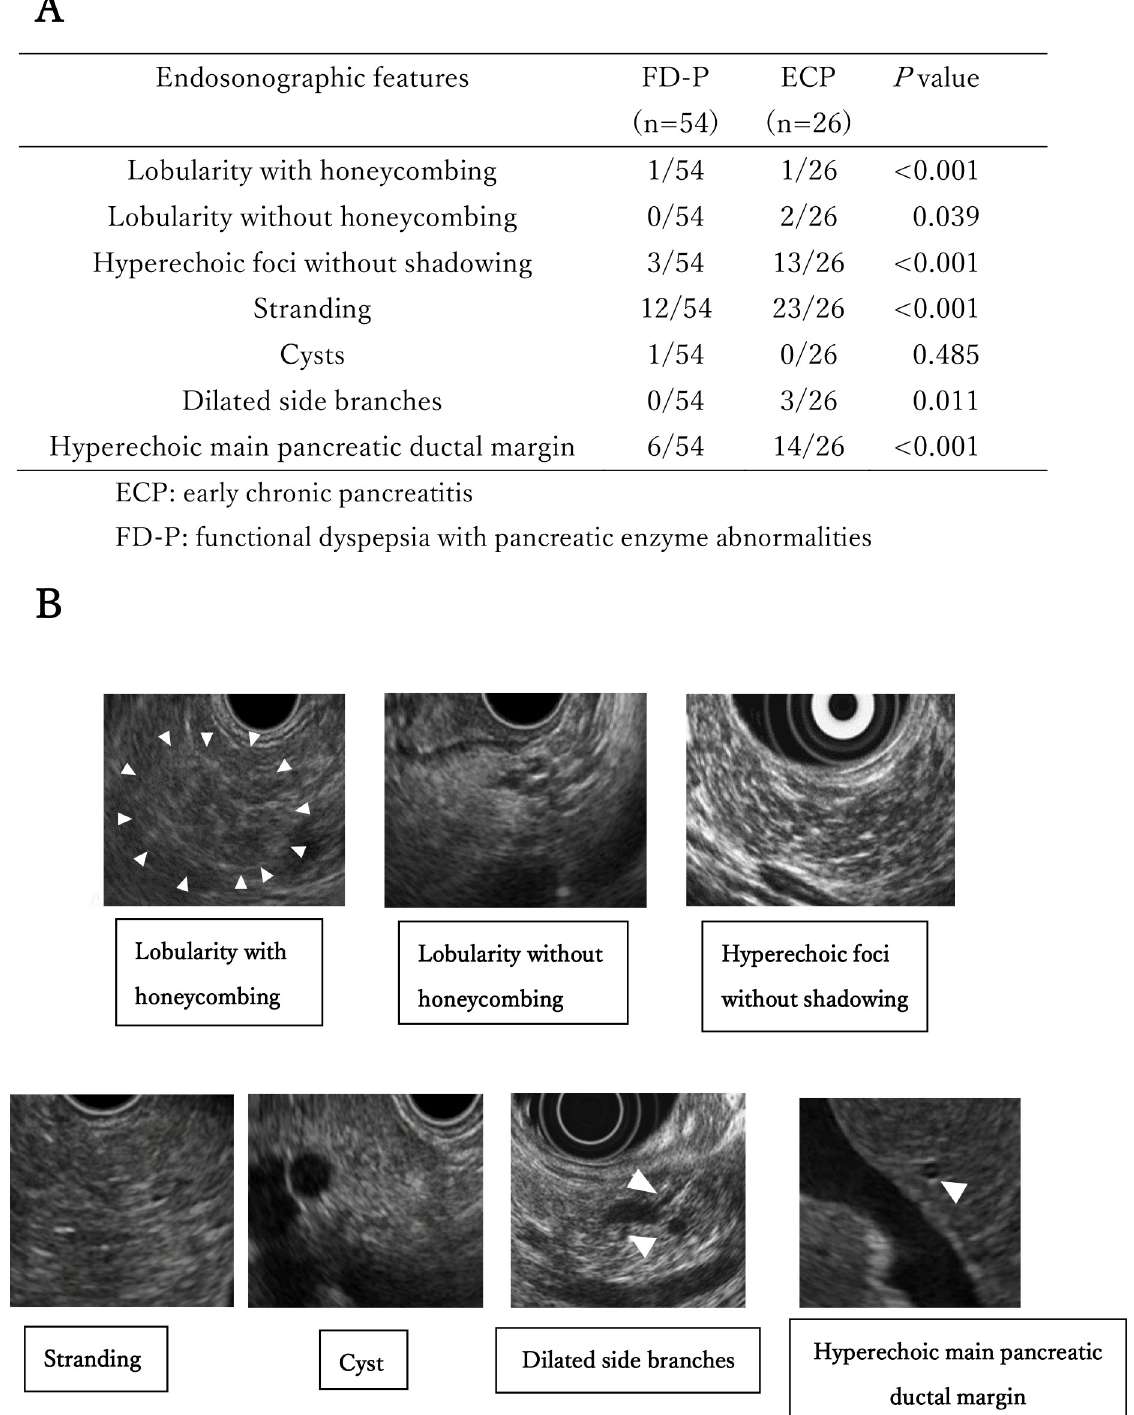
Fig 2. Comparison of endosonographic features between ECP and FD-P patients. Fig 2A We compared seven items of endosonographic features between FD-P and ECP patients. Fig 2B. We showed representative endosonographic features (lobularity with honeycombing, lobularity without honeycombing, hyperechoic foci without shadowing, stranding, cyst, dilated side branches, and hyperechoic main pancreatic ductal margin) of patients with ECP. Arrows show lobularity with honeycombing or dilated side branches, or hyperechoic main pancreatic ductal